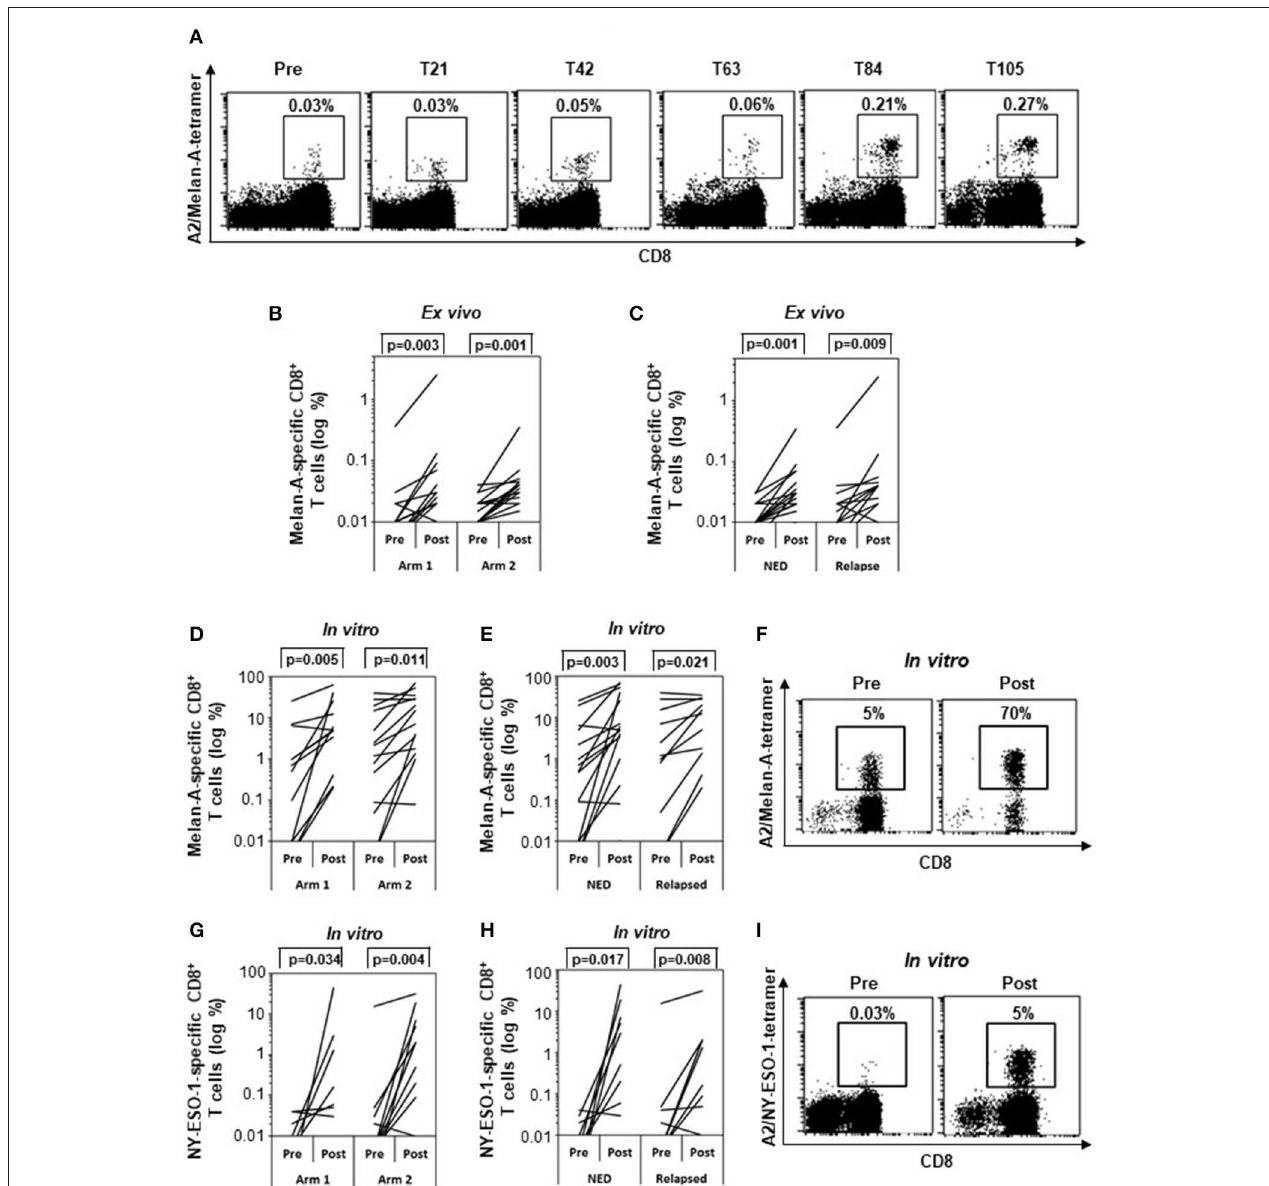
FIGURE 3 | Specific immune response. Frequencies of Melan-A– (A–F) and NY-ESO-1–specific (G–I) CD8 + T cells analyzed by tetramer staining ( n = 29). (A) Kinetic analysis of the frequency of Melan-A–specific T cells between pretreatment and posttreatment samples (T21, T42, T63, T84, T105) in one representative patient (patient 29). (B,C) Variation of Melan-A–specific T cell percentage between pretreatment and posttreatment ex vivo samples in arm 1 ( n = 15) vs. arm 2 patients ( n = 14) (B) and in patients with no evidence of disease (NED) ( n = 16) vs. relapsed patients ( n = 13) (C) . (D,E,G,H) Variation of Melan-A– ( n = 28) (D,E) and NY-ESO-1–specific ( n = 26) (G,H) T cell percentage after short term in vitro expansion, in arm 1 vs. arm 2 patients (D,G) and in patients with no evidence of disease (NED) vs. relapsed patients (E,H) . (F,I) . Representative staining (patient 09) of short term in vitro expansion before (pre) and after (post, T105) stimulation with Melan-A (F) and NY-ESO-1 (I) peptides. p values were calculated by Wilcoxon signed-rank test.